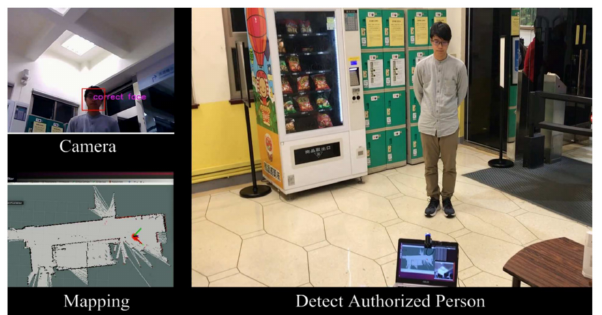
Figure 36. Face recognition of authorized target in second indoor environment.